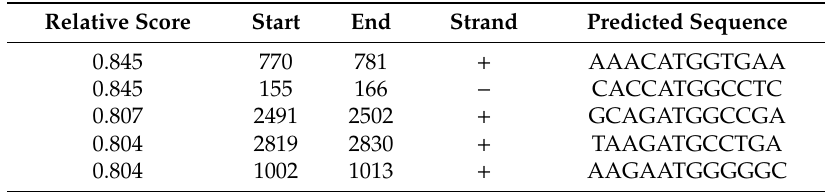
Table 1. JASPAR analysis results for YY1 binding sites located within the promoter of BIRC5